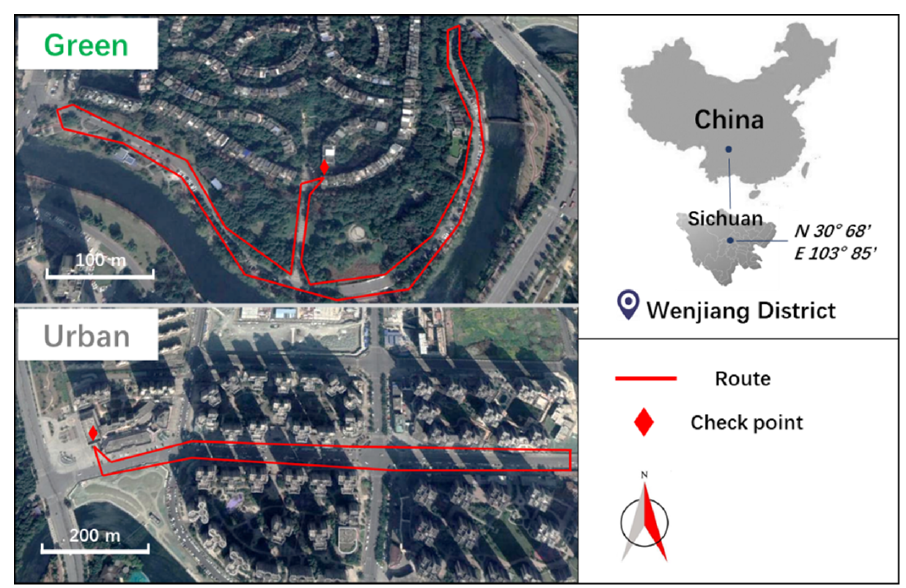
Figure 1. Location of the study area and the two walking routes in the green space and urban area.